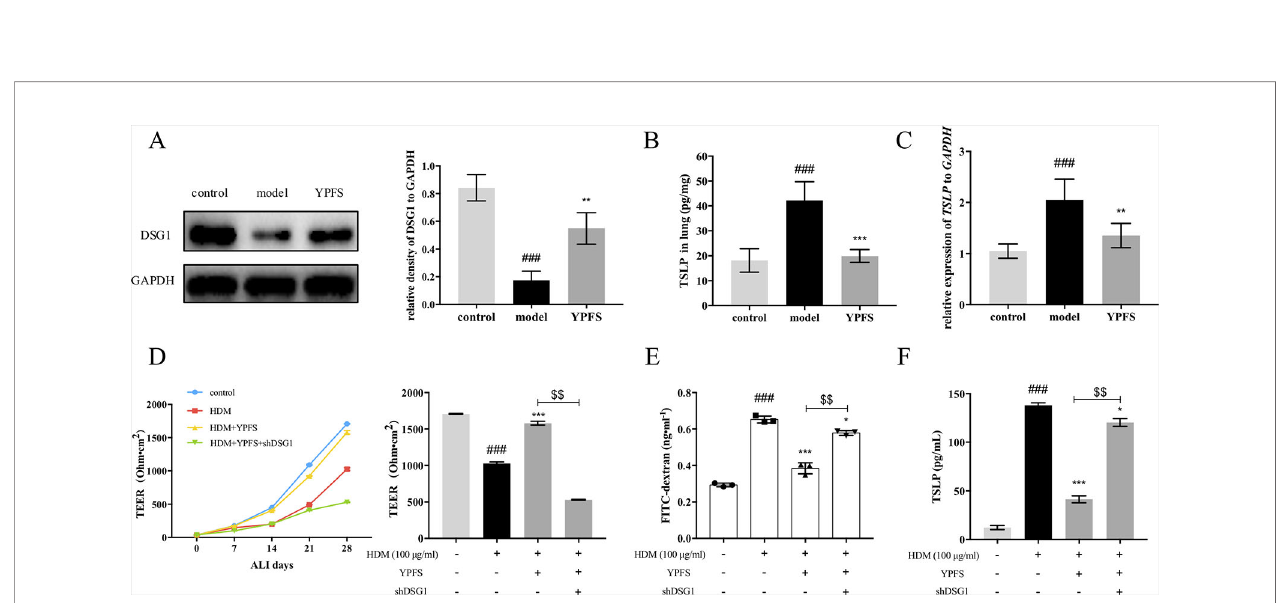
FIGURE 7 | YPFS could signi fi cantly restore DSG1 de fi ciency and reduced TSLP in vivo and in vitro . Firstly, the effects of YPFS on DSG1 and TSLP were evaluated in the HDM-induced asthma recurrence model. (A) DSG1 expression in lung was detected by Western blot; Protein level (B) and mRNA level (C) of TSLP in lung was detected by ELISA and RT-QPCR, respectively. YPFS administration during remission phase was potent restoring DSG1 and degrading TSLP in vivo . (All data represent mean ± SD from three independent experiments performed in triplicate, n = 6, * P < 0.05, *** P < 0.001 versus model; ### P < 0.001 versus control); And in vitro , 16HBE cells were treated with HDM at 100 m g/ml for 24 h, and then incubated with YPFS for 72 h. DSG1 were knockdown by shRNA thereafter. After forming a con fl uent monolayer, cells in all wells were differentiated at ALI for 28 days. Results indicated that YPFS treatment in vitro markedly recovered the barrier integrity as evidenced by (D) TEER, and (E) FITC-dextran in fl ux measurement detection on day 28, which were abrogated by subsequent knockdown of DSG1; In addition, (F) TSLP in culture medium detected by ELISA also suggested that YPFS administration could signi fi cantly reduce the TSLP overexpression induced by HDM. However, shDSG1 afterwards remarkably elevated the TSLP expression, which suggested that YPFS might exert its effects on barrier integrity via DSG1 and TSLP. (All data represent mean ± SD from three independent experiments performed in triplicate, n = 3, ### P < 0.001 versus control; * P < 0.05, ** P < 0.01 versus HDM, *** P < 0.001 versus HDM; $$ P < 0.01 versus HDM+YPFS). YPFS, Yu-Ping-Feng-San; TEER, transepithelial electrical resistance; TSLP, thymic stromal lymphopoietin.